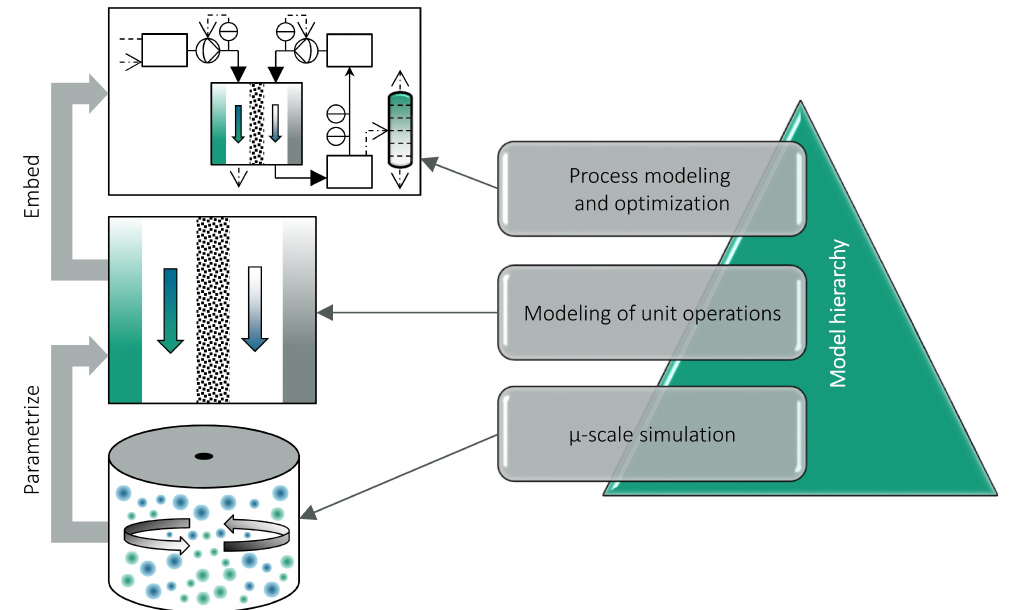
Figure 1. Bottom-up approach to process modeling. The parameters of unit models are derived from simulations on a smaller scale. Then, the unit models are embedded in a process